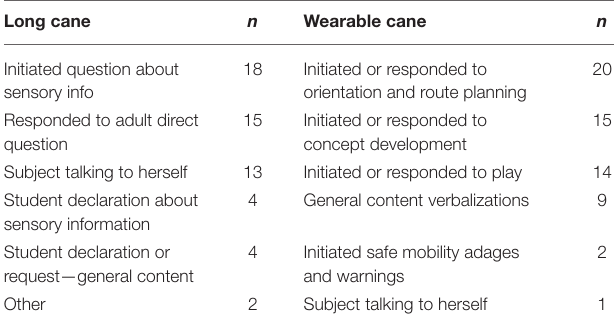
TABLE 3 | Subject language content when walking using long cane and wearable